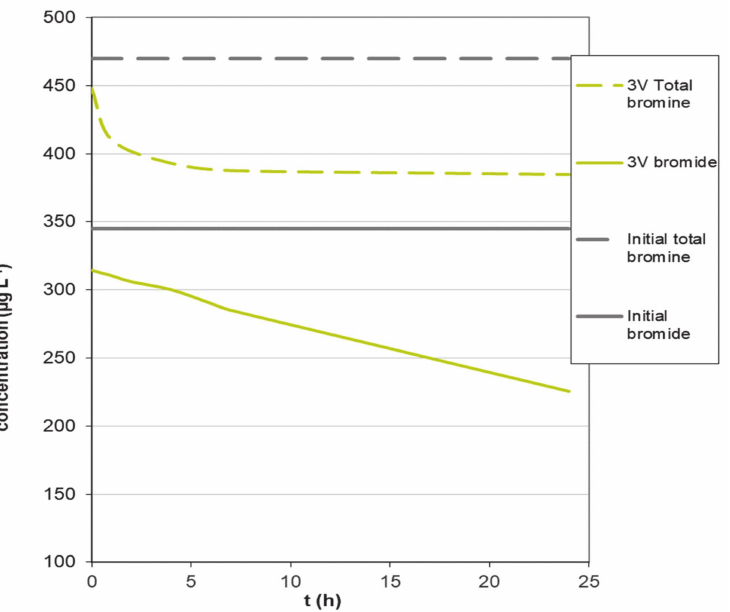
Figure 4. Variation of bromide concentration in an experiment in the absence of activated carbon at 3 V.